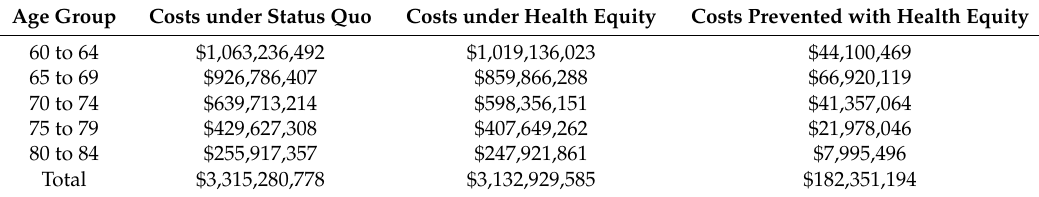
Table 3. Potential herpes zoster related costs saved among elderly blacks by achieving health equity in shingles vaccine